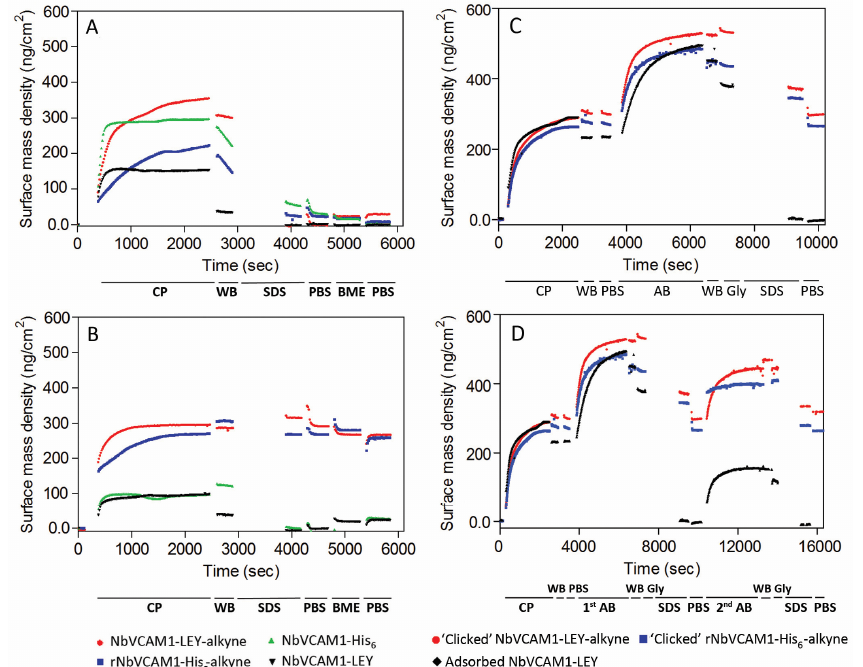
Figure 2. Ellipsometric results for the CuAAC-mediated coupling of different NbVCAM1 variants in acetate buffer pH 4.0 to: ( A ) carboxylated; and ( B ) azidified silicon wafers. The coupling process (CP) was followed by consecutive washing steps with washing buffer (WB), SDS, phosphate buffer saline (PBS), BME and PBS. Data were recorded in real-time and in quadruplicate and one representative curve is presented. ( C ) A one-cycle human VCAM1 antigen (R & D Systems) binding (A,B) on different nanobody-conjugated silicon surfaces. The nanobodies were immobilized using either CuAAC (for the rNbVCAM1-His 6 -alkyne and NbVCAM1-LEY-alkyne) or physisorption (for the NbVCAM1-LEY). Binding was followed by consecutive washing steps with WB, Glycine-HCl, SDS and PBS. ( D ) A two-cycle AB binding process on similar slides. Measurements were carried out in duplicate and one representative curve is shown.